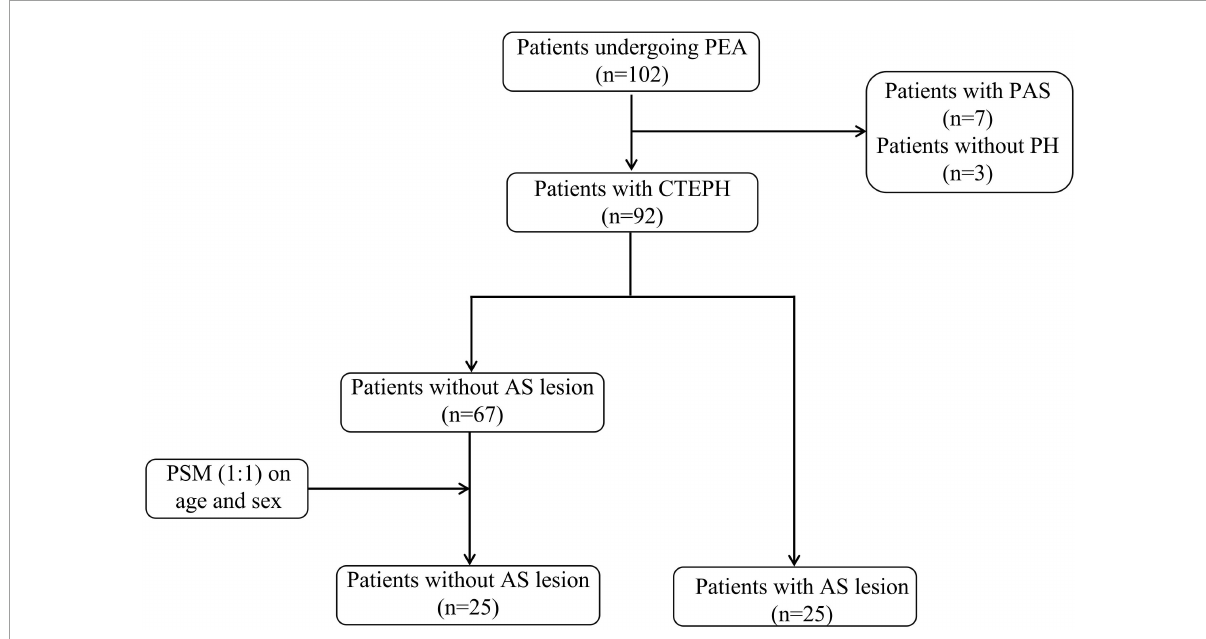
FIGURE1 The flowchart of the patient selection process. PEA, pulmonary endarterectomy; PAS, pulmonary artery sarcoma; PH, pulmonary hypertension; CTEPH, chronic thromboembolic pulmonary hypertension; AS, atherosclerosis; PSM, propensity score matching.